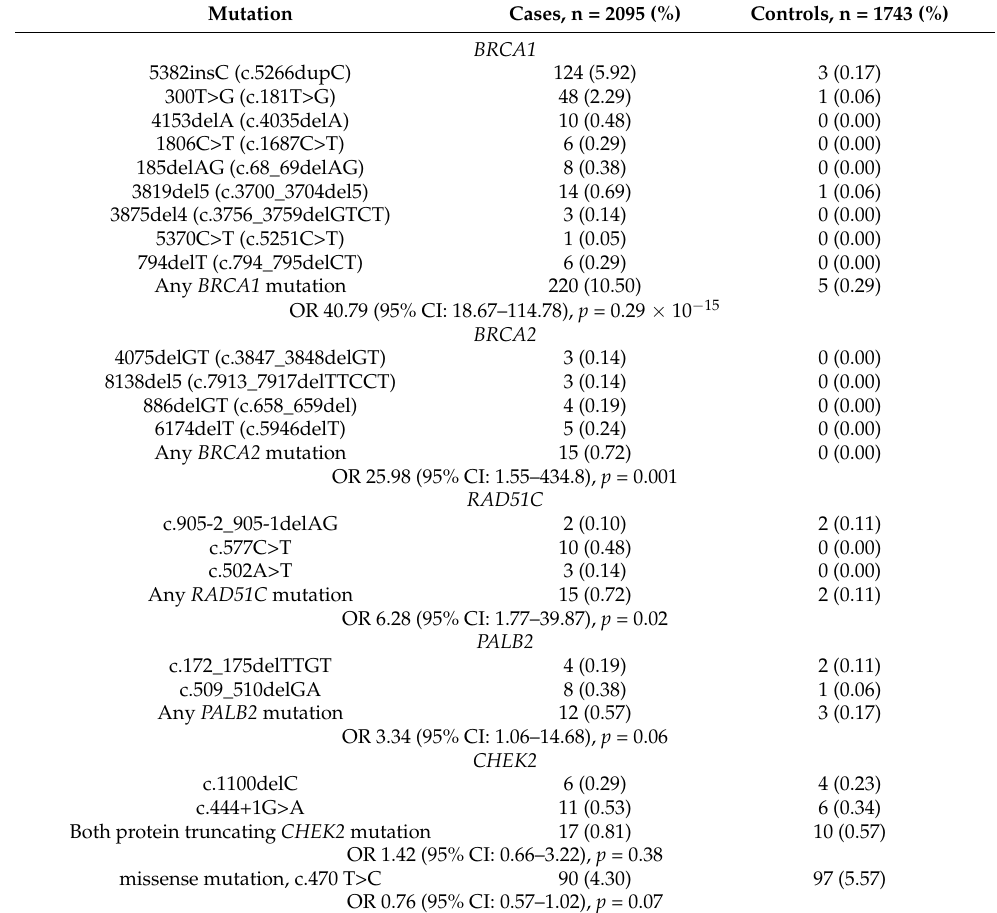
Table 1. The prevalence and association of tested 21 founder/recurrent mutations in BRCA1 , BRCA2 , RAD51C , PALB2 , and CHEK2 genes with ovarian cancer